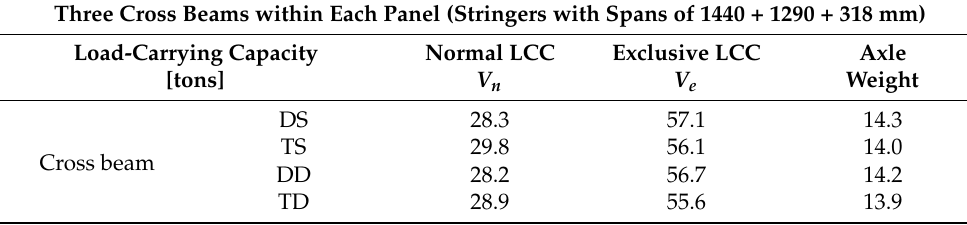
Table 7. Cross beam load-carrying capacity when three cross beams are used per panel. Three Cross Beams within Each Panel (Stringers with Spans of 1440 + 1290 + 318 mm)